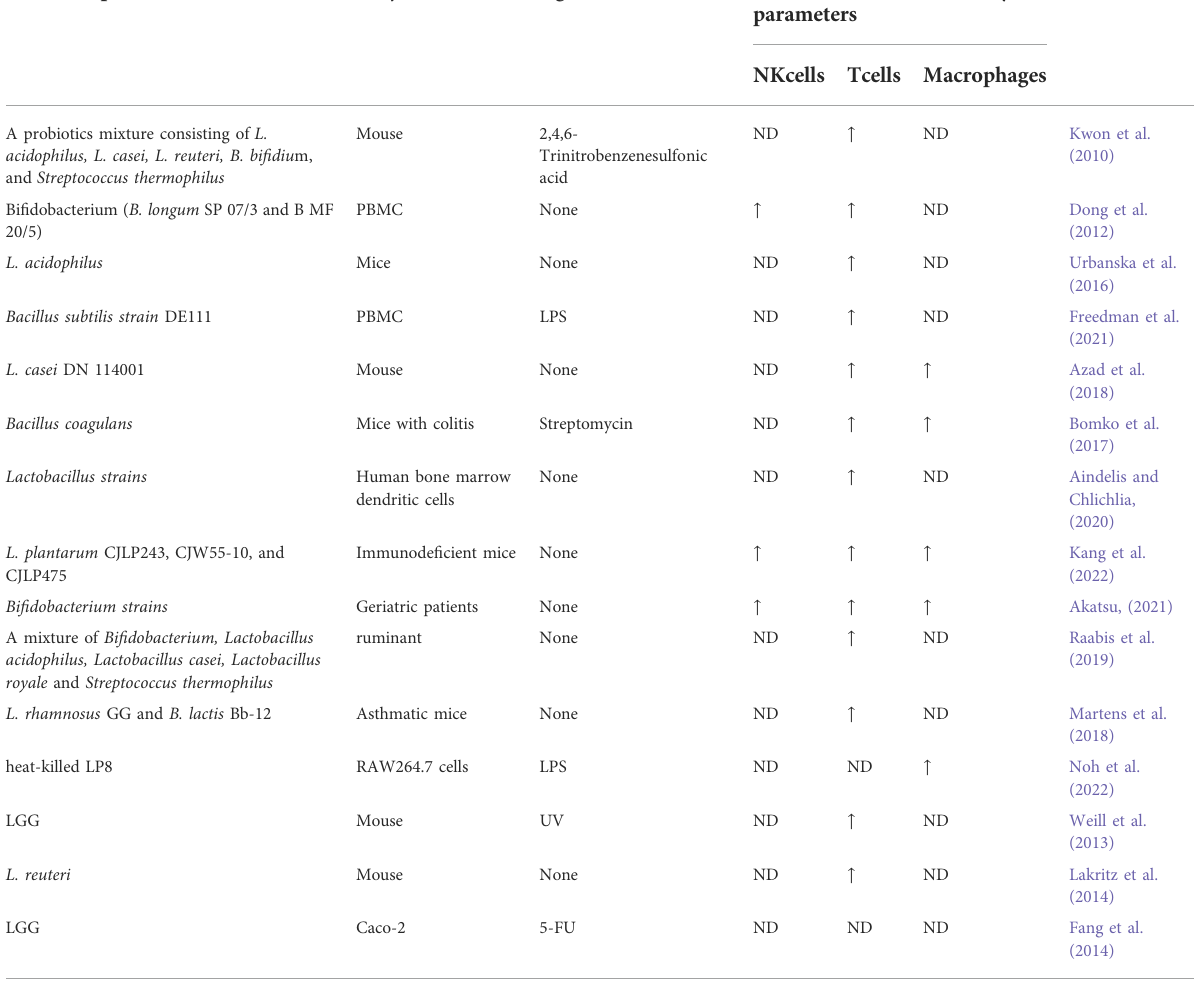
TABLE 1 Immunomodulatory effect of probiotics described in animals or cell